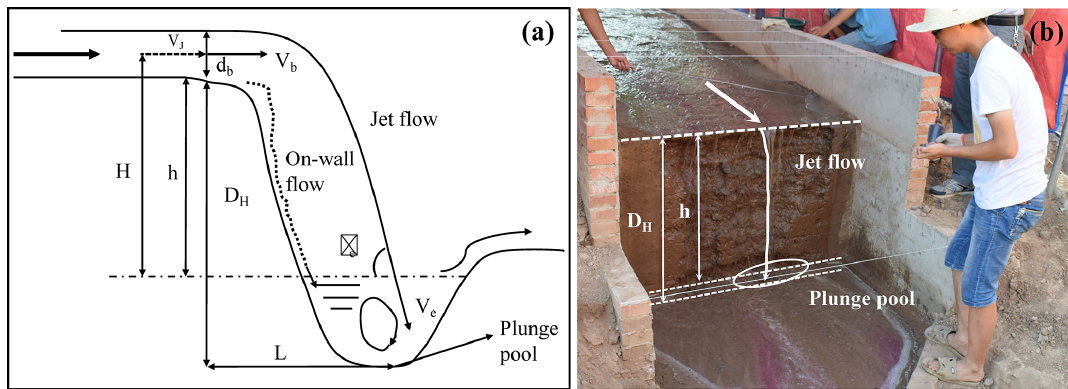
Figure 3. Sketch of jet flow at the gully headcut (a) . The plunge pool at the gully bed (b) .